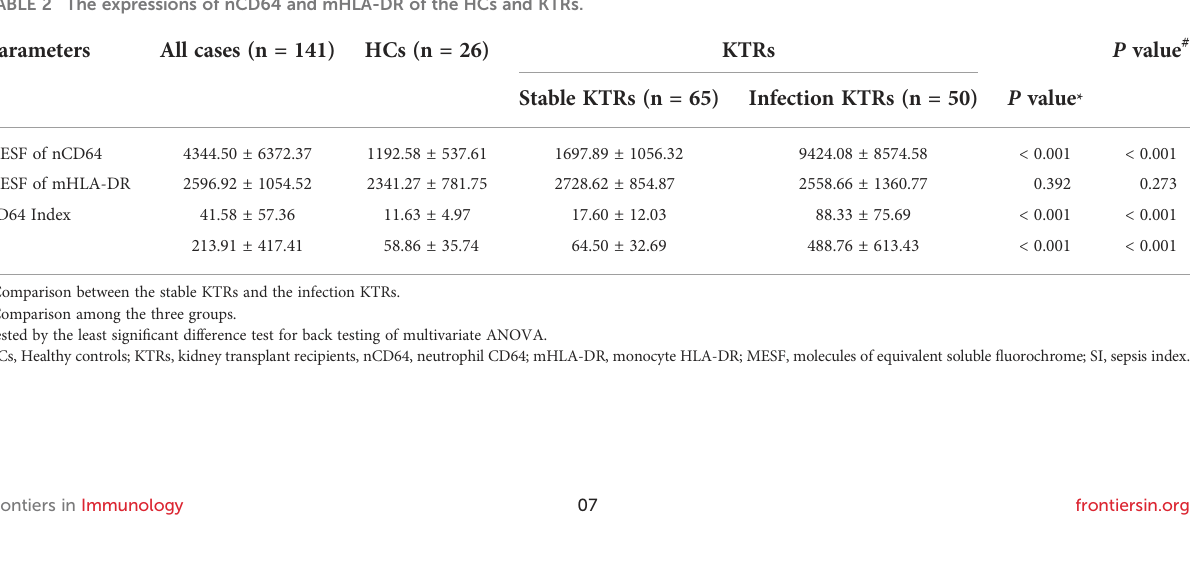
TABLE 2 The expressions of nCD64 and mHLA-DR of the HCs and KTRs. Parameters